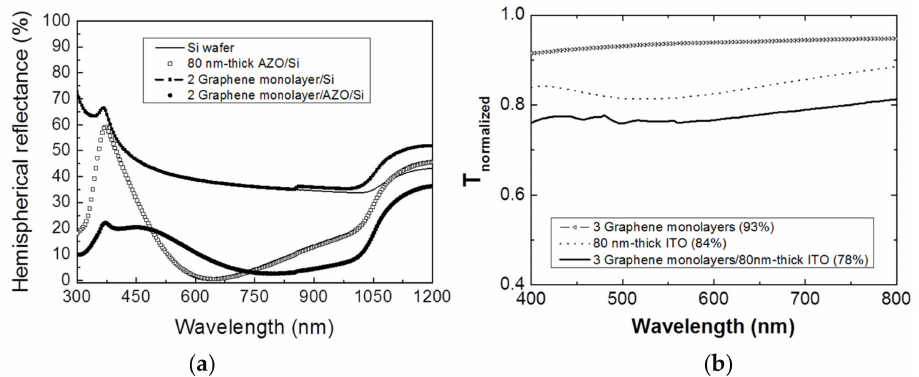
Figure 3. ( a ) Total (hemispherical) reflectance spectra in the visible range (300–875 nm) of a system of two GML stacked on top of a 80-nm-thick AZO film on silicon (fill circle symbol), a 80-nm-thick AZO film on silicon (open circle symbol), two GML on silicon (dot line), and the bare silicon wafer (straight line); ( b ) Normalized transmittance spectra in the visible range (400–800 nm) of a system of three GML stacked on top of a 80-nm-thick ITO film on a glass substrate (straight line) and a 80-nm-thick ITO film on glass (dot line) and 3 GML on glass (triangle symbol).